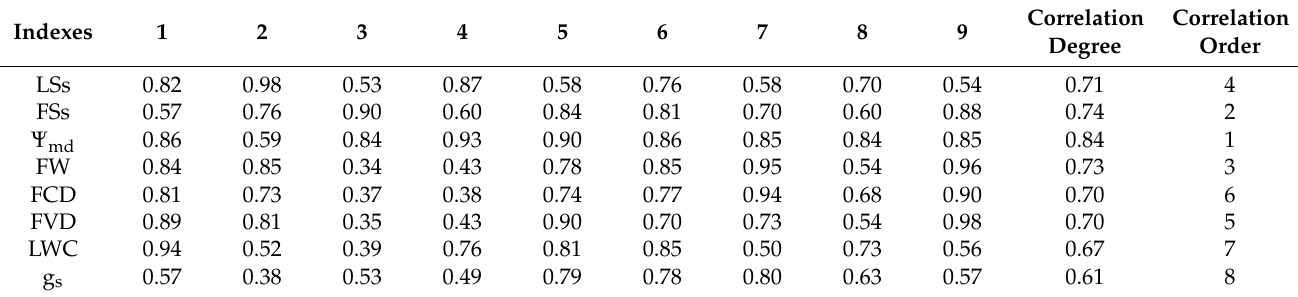
Table 1. Gray correlation